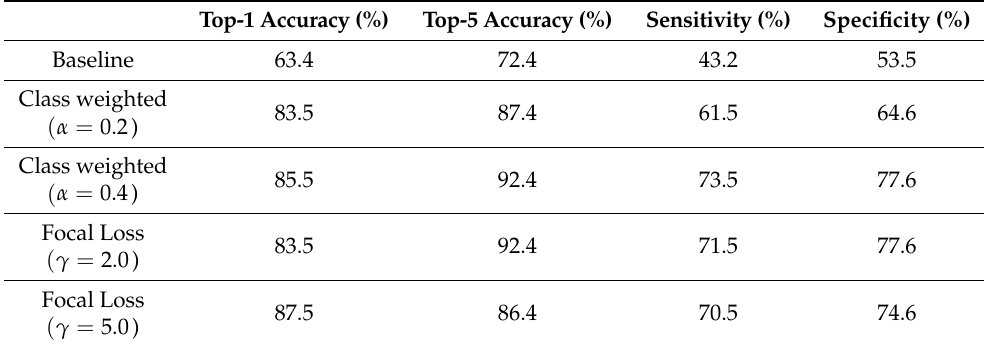
Figure 6. Training and validation loss curves for the deep learning model. Table 4. Performance evaluation on UBD Botanical + PlantCLEF test set.